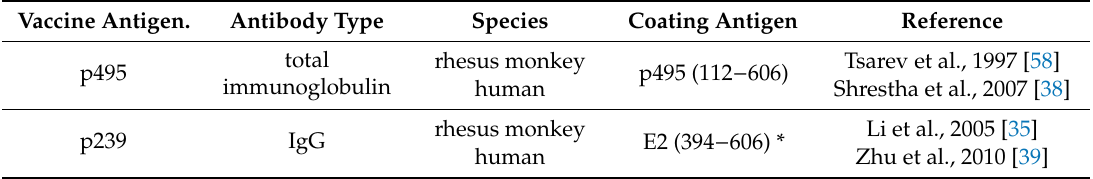
Table 1. Di ff erent antigens used in the ELISA methods for supporting the vaccine clinical trials or preclinical development. Vaccine